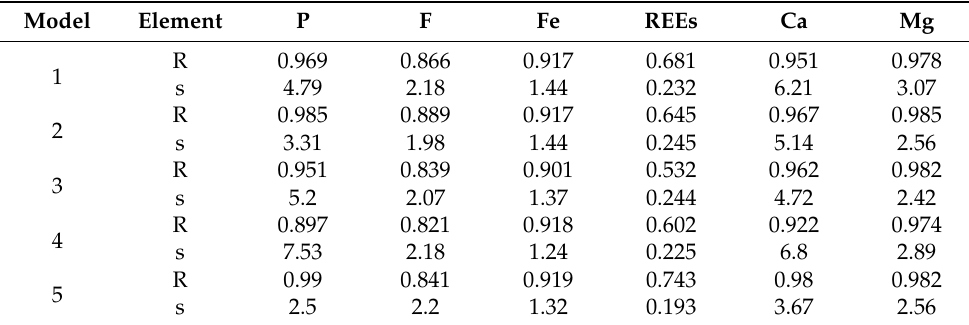
Table 4. The comparison of regression models in the case of the Toolse 1 sample.